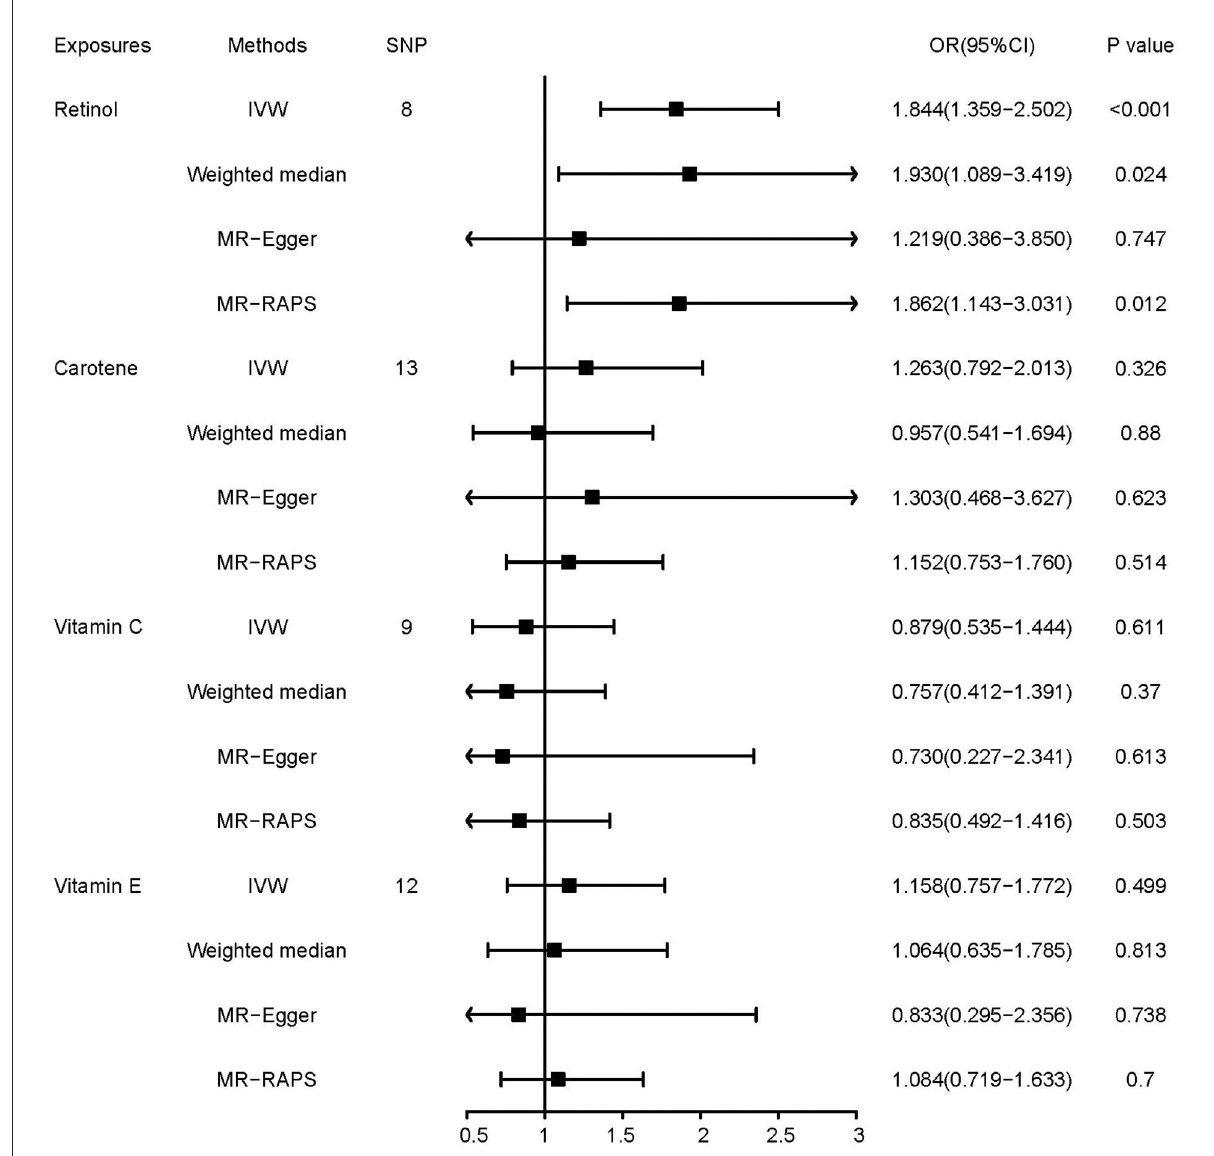
FIGURE1 Mendelian randomization (MR) estimates of the associations of antioxidant vitamins with lung